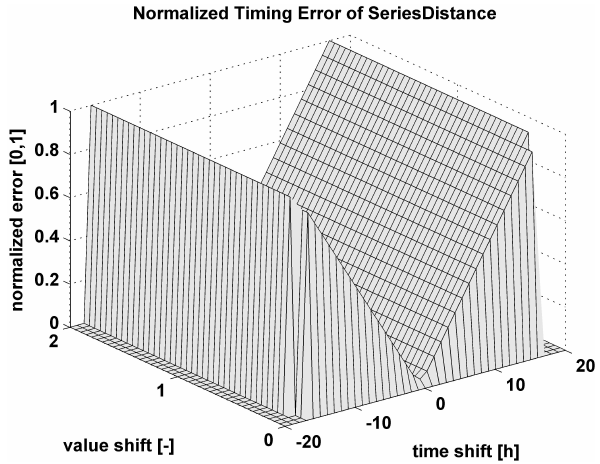
Fig. 7. Error surface of the value/amplitude error of the Series Dis- tance (SD) for synthetic, triangular events as shown in Fig. 1. Simu- lations are shifted in time (offset range [ − 20h, 20h]) and amplitude (multiplier range [0, 2]). The error surface is normalized to [0, 1] by means of division with the maximum error.